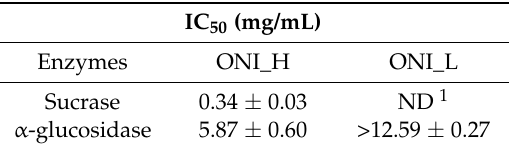
Table 2. The half-maximal inhibitory concentration (IC 50 ) values for rat intestinal α -glucosidase and sucrase by two different onion extracts (ONI_H and ONI_L).